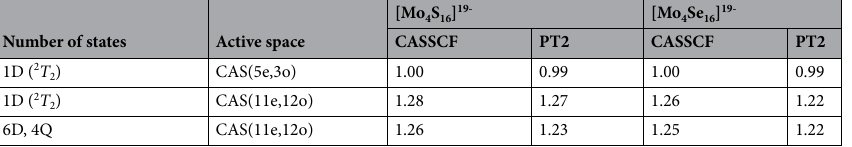
Table 1. Z values in GaMo 4 S 8 and GaMo 4 Se 8 . The Z values are given for different types of reference active spaces and different number of states in the spin-orbit treatment. The abbreviations refer to doublet (D) and quartet (Q) states. PT2 stands for NEVPT2.